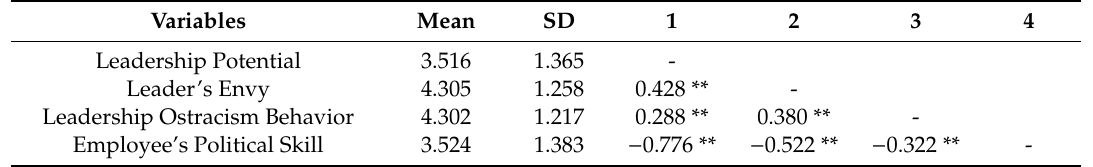
Table 4. Means, standard deviations, and correlation coe ffi cients of